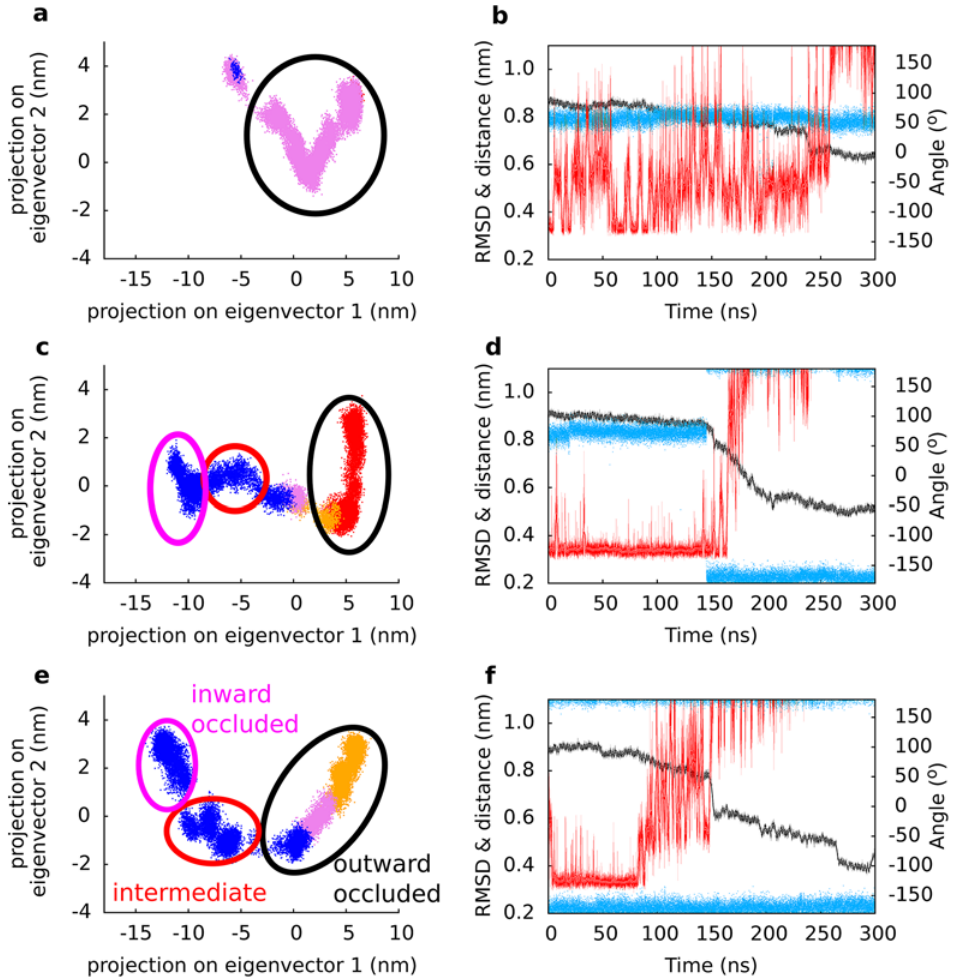
Fig 8. Correlation analysis. Panel (a, c, e) show movements of a GltPh protomer along the two largest eigenvectors (translation and rotation of the domains relative to each other) observed in the simulations of protomer A, B and C, respectively. Each dot represents the projection of one frame in the trajectory onto the 2 dimension of eigenvectors 1 (translation) and 2 (rotation). Four distinct periods of the trajectory are color coded: The first part of the trajectory (red) represents the outward-occluded state. A shift to orange marked the rotation of T308. Rotation of side chain of Y195 notifies the transition to the third period (pink). The fourth region shown in blue represents the period after opening of the intracellular interaction network. The intermediate state is reached in the populated region in the middle of the plot, after opening of the intracellular interaction network. Panel (b, d, f) show an overlay of the time evolution of the RMSD (black), the rotational state of the side chain of T308 (blue) and the side chain – side chain distance between E192 and K290 (red) of protomer A, B and C,